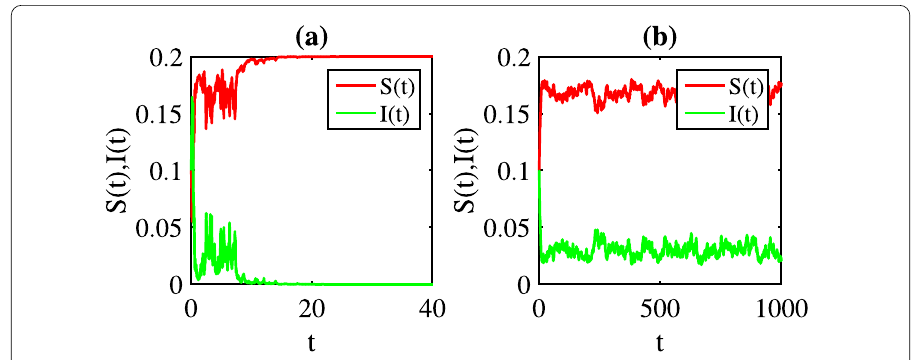
Figure 3 Time sequence diagram of stochastic system (7): ( a ) case (iv) of Theorem 2.1, ( b ) case of Theorem